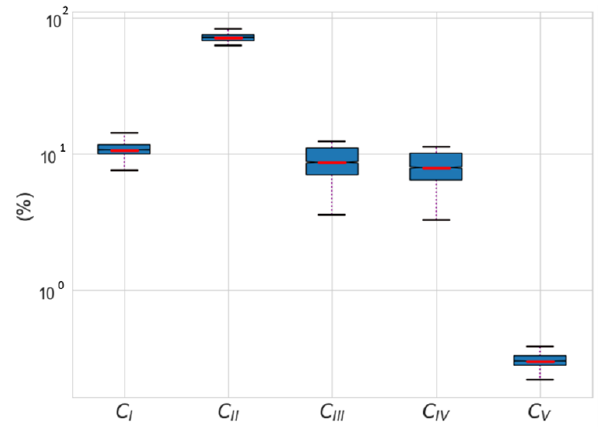
Figure 11. Total charge